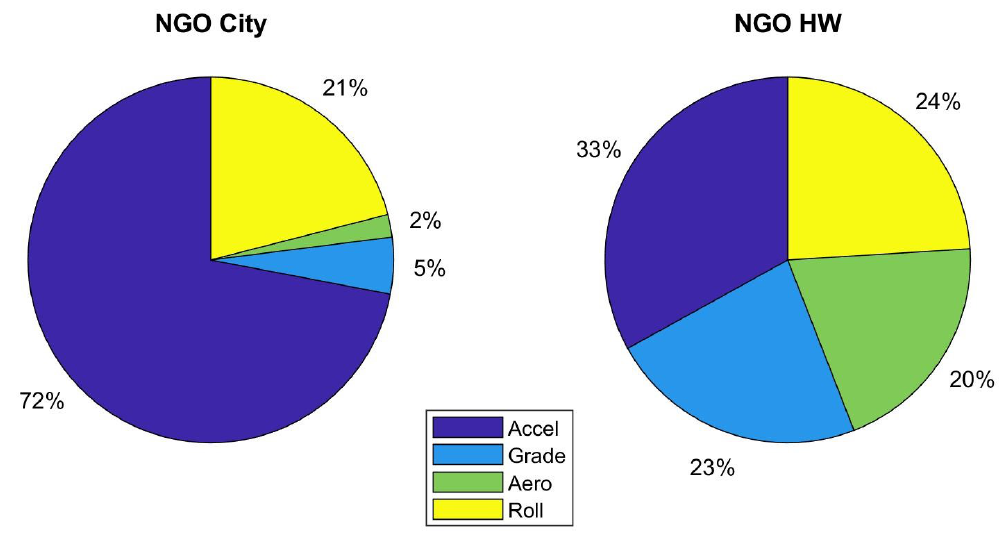
Figure 10. Contribution of each driving-power term in city and highway driving in Nagoya,